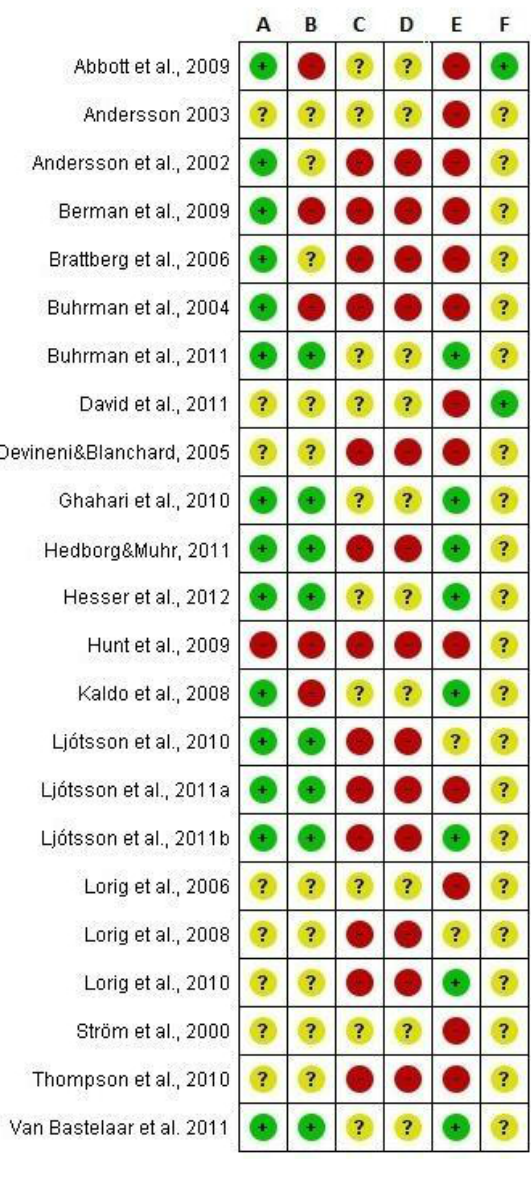
Figure 3. Risk of bias summary: review authors' judgements for each included study about each risk of bias item. A=Random sequence generation (selection bias); B=Allocation concealment (selection bias); C=Blinding of participants and personnel (performance bias); D=Blinding of outcome assessment (detection bias); E=Incomplete outcome data (attrition bias); F=Selective reporting (reporting